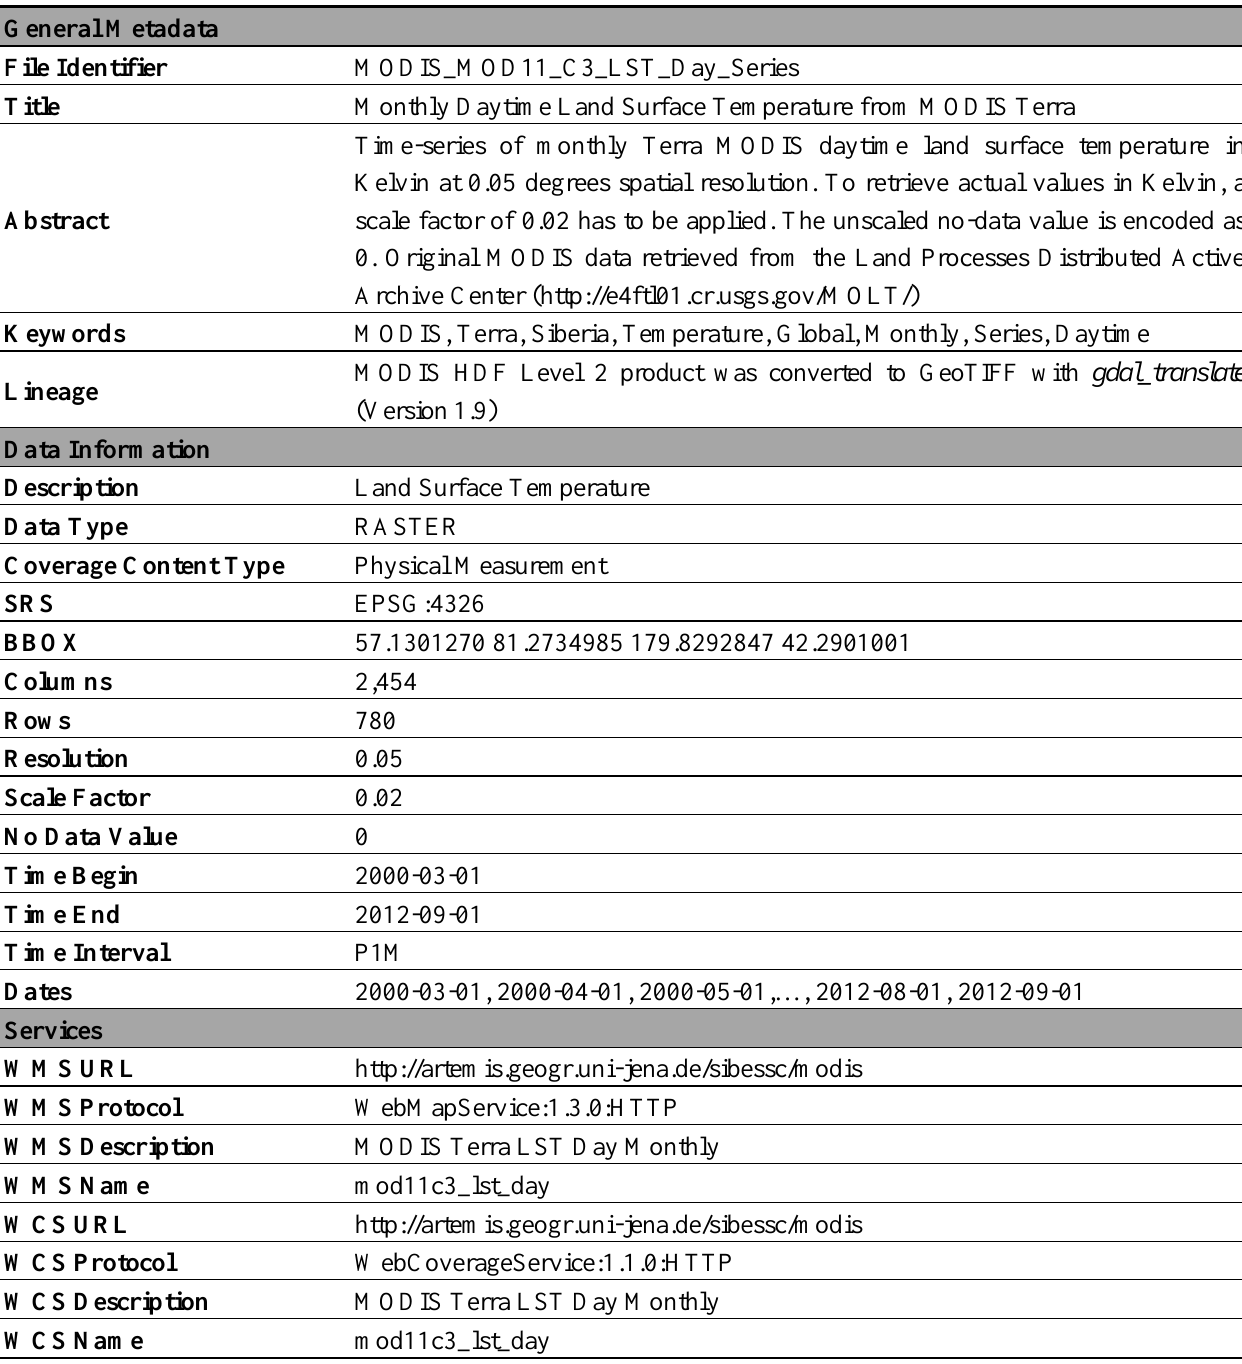
Table 7. Excerpt of information stored in the metadata records (example of MODIS Terra land surface temperature time-series